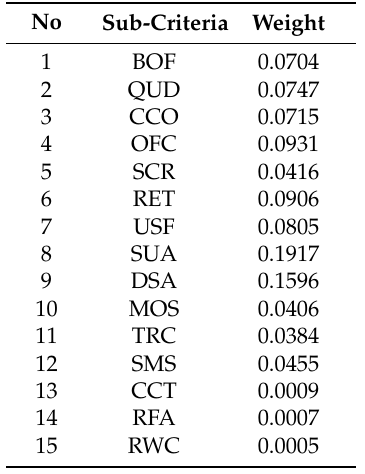
Table 4. Results of the FANP model.